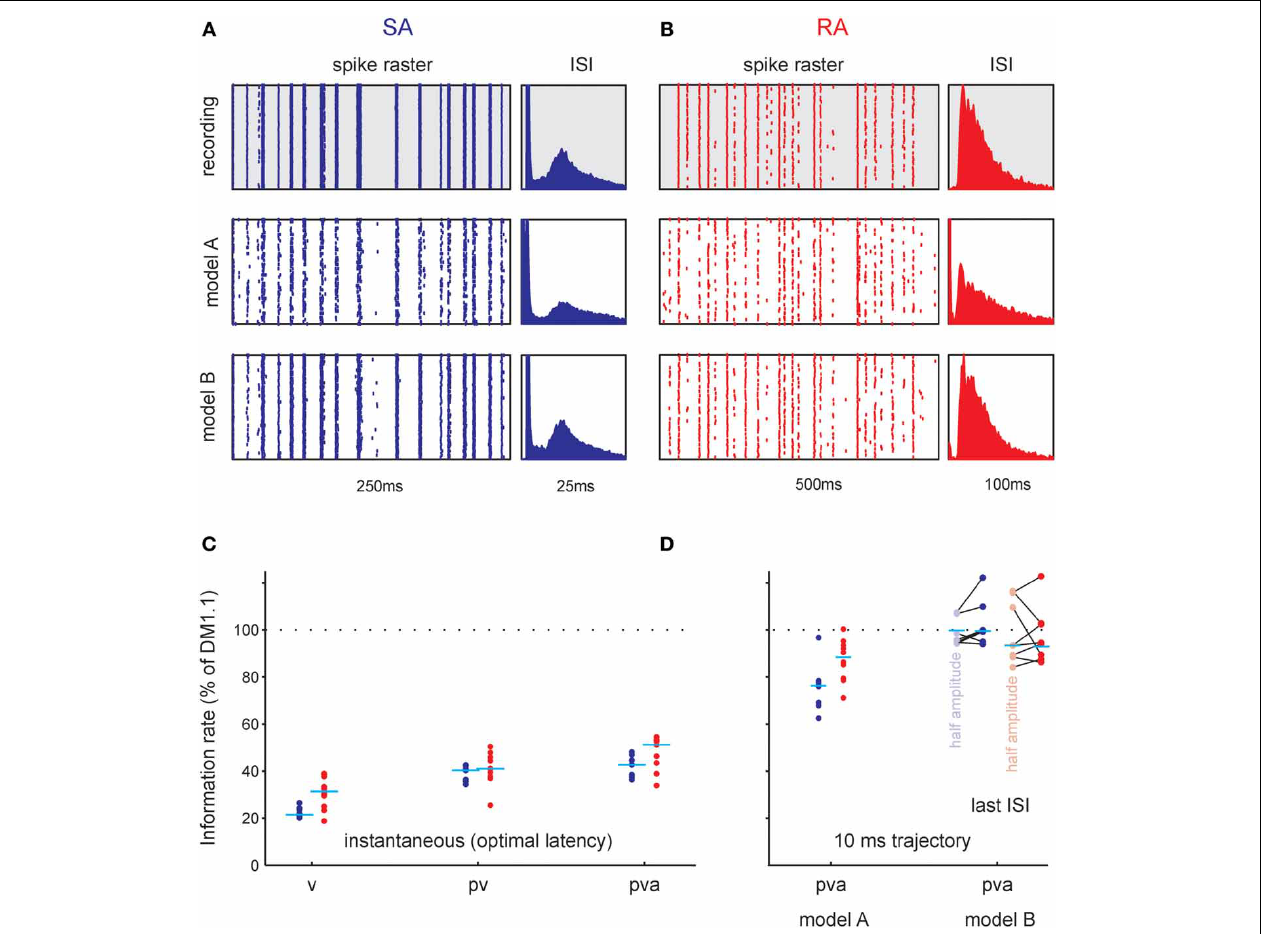
FIGURE 10 | Functional analysis of total information rate using the STM model. (A,B) Raster plots (left) and inter-spike interval distributions (ISI, right) as recorded (gray background), and generated by two probabilistic models (white background, cf. Figure 9 ). (A) Typical SA cell. Each row corresponds to one trial with the frozen white noise stimulus. Model A ignores the spike intervals. It reproduces the raster fairly well but introduces too many small intervals. Model B takes the spike intervals into account and clearly reproduces the cells’ spike train better. Furthermore, it captures the refractory period and the doublet spiking of the cells better, as can be seen from the inter-spike-interval histograms (right). (B) Same as (A) but for a typical RA cell. (C,D) . Comparison of information rate with DM1.1. Data from all cells; horizontal lines depict medians. (C) Information rate for instantaneous encoding of kinematic